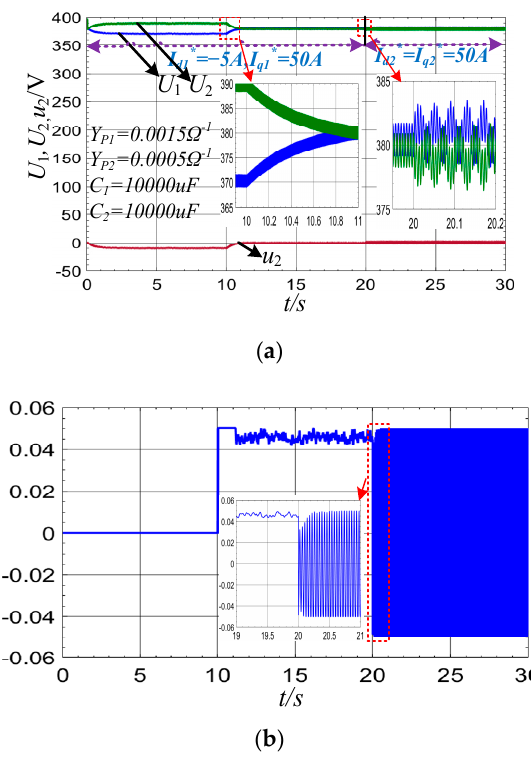
Figure 11. Waveforms without considering the amplitude of I vd . ( a ) DC voltages. ( b ) The instruction value s 0 .